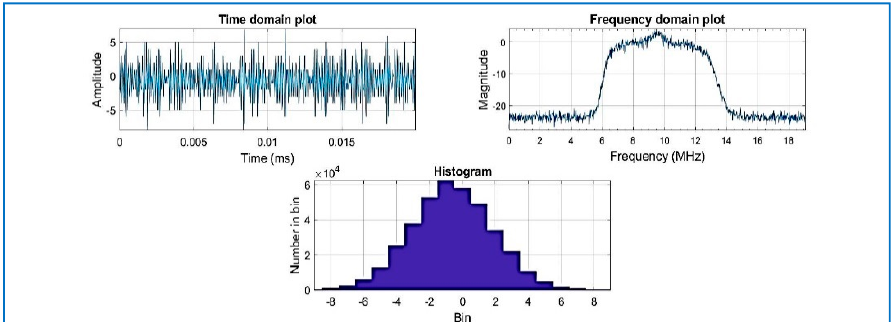
Figure 8. Raw IF data plotted signal of Dataset 1 (not compressed).